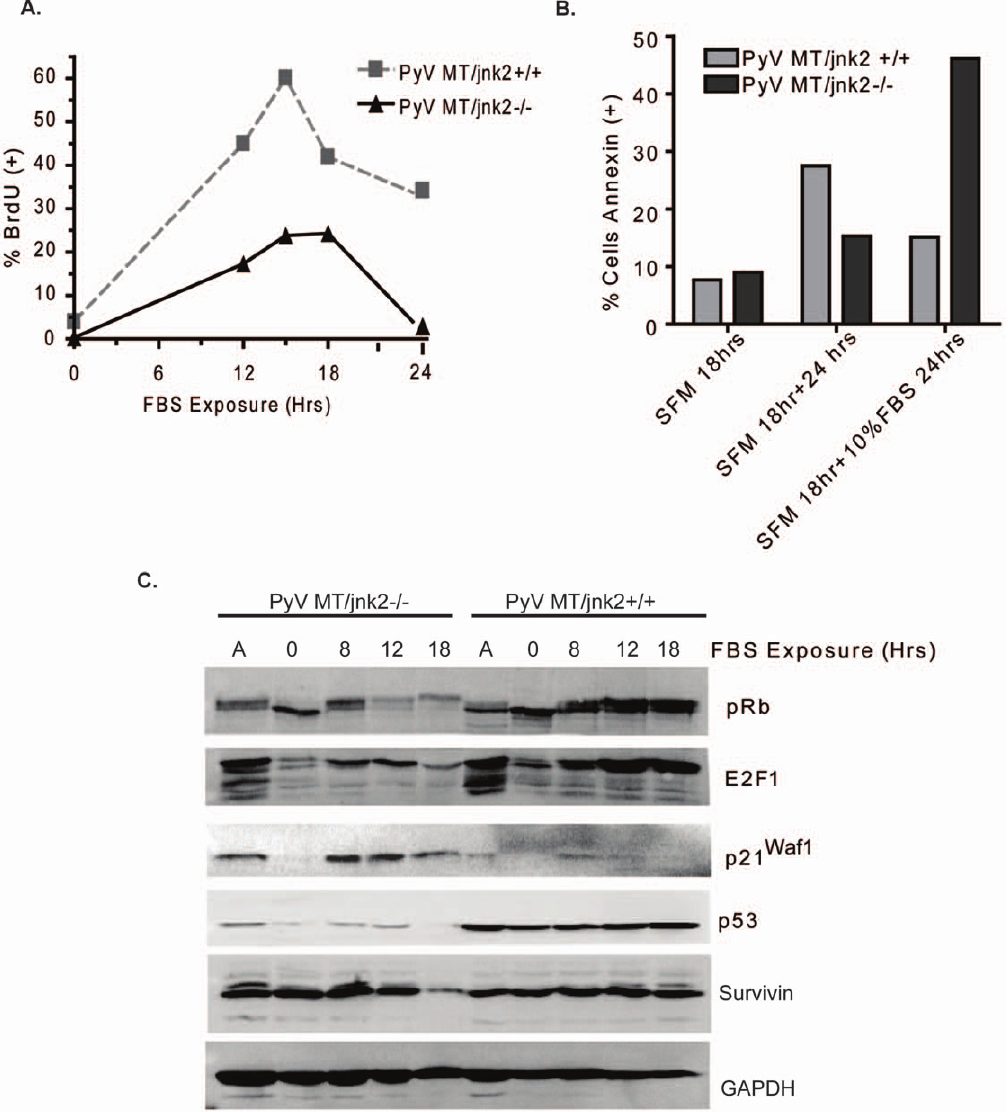
Figure 5. Serum treatment of G 1 arrested cells induces cell death in PyV MT/ jnk2 2 / 2 cells. A ). PyVMT/ jnk2 + / + and PyVMT /jnk2 2 / 2 cells were serum starved for 24 hours and then treated with 10% FBS containing medium. Serum stimulated cells were pulsed with BrdU two hours prior to harvesting and then stained with BrdU primary antibody followed by BrdU detection using flow cytometry. BrdU positivity data are presented as percent positive cells in total cell population; B ). PyVMT/ jnk2 + / + and PyVMT /jnk2 2 / 2 cells were serum starved for 24 hours and then treated with 10% FBS containing medium. After 24 hours of serum starvation, cells were either cultured in fresh SFM or medium containing 10% FBS and harvested 24 hours later. Cells were evaluated for Annexin positivity using flow cytometry. Data are expressed as percent positive cells of the total population; C ). Cells were serum starved as above and then harvested at indicated time points after 10% FBS stimulation to assess expression of various cell cycle associated proteins using western blot analysis with primary antibodies directed towards the indicated proteins. GAPDH was used to compare even sample loading.